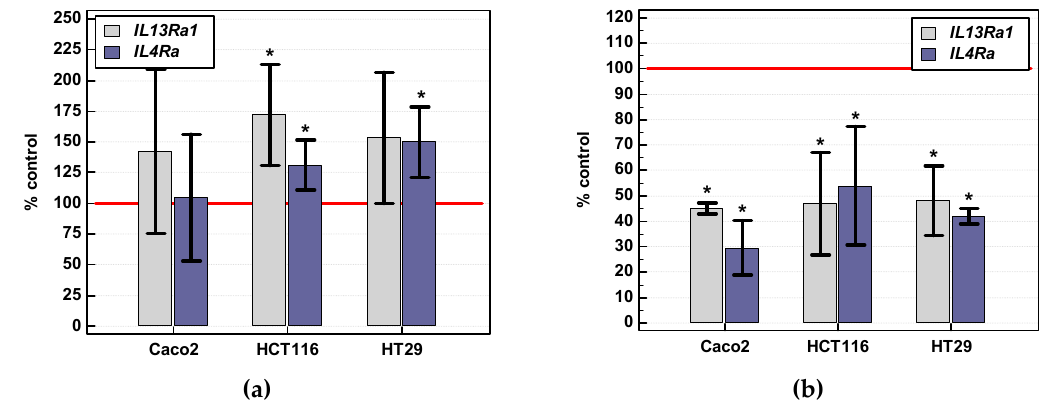
Figure 11. IL13Ra1 and IL4Ra expression under stress conditions: ( a ) serum withdrawal; ( b ) chemically induced hypoxia. Bars represent mean ( n = 2–4) of relative expression of receptor transcripts in cells grown with 0.5% FBS or stimulated with 200 µM CoCl 2 for 24 h as compared to controls (cells grown with 10% FBS or unstimulated), expressed as a percentage. Reference expression level of control/untreated cells (100%) is represented by red horizontal line. Statistically significant differences in treated cells as compared to their respective controls are marked with asterisks (*) (analyzed using t -test for one mean).